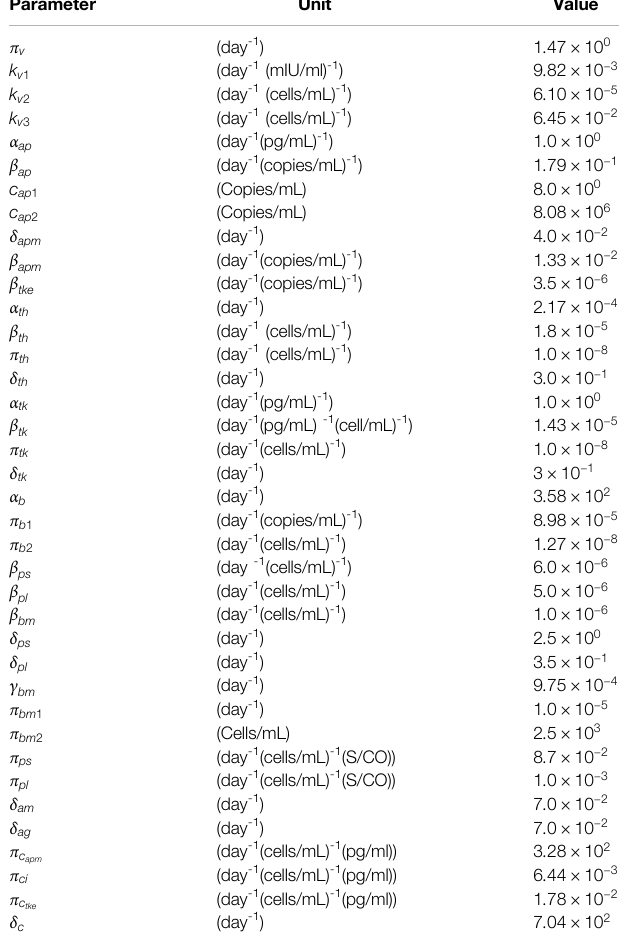
TABLE 5 | Model parameters values that fi t survivors ’ data. The parameter presented in Table 2 were estimated using DE. The other values were based on the work of Bonin et al.